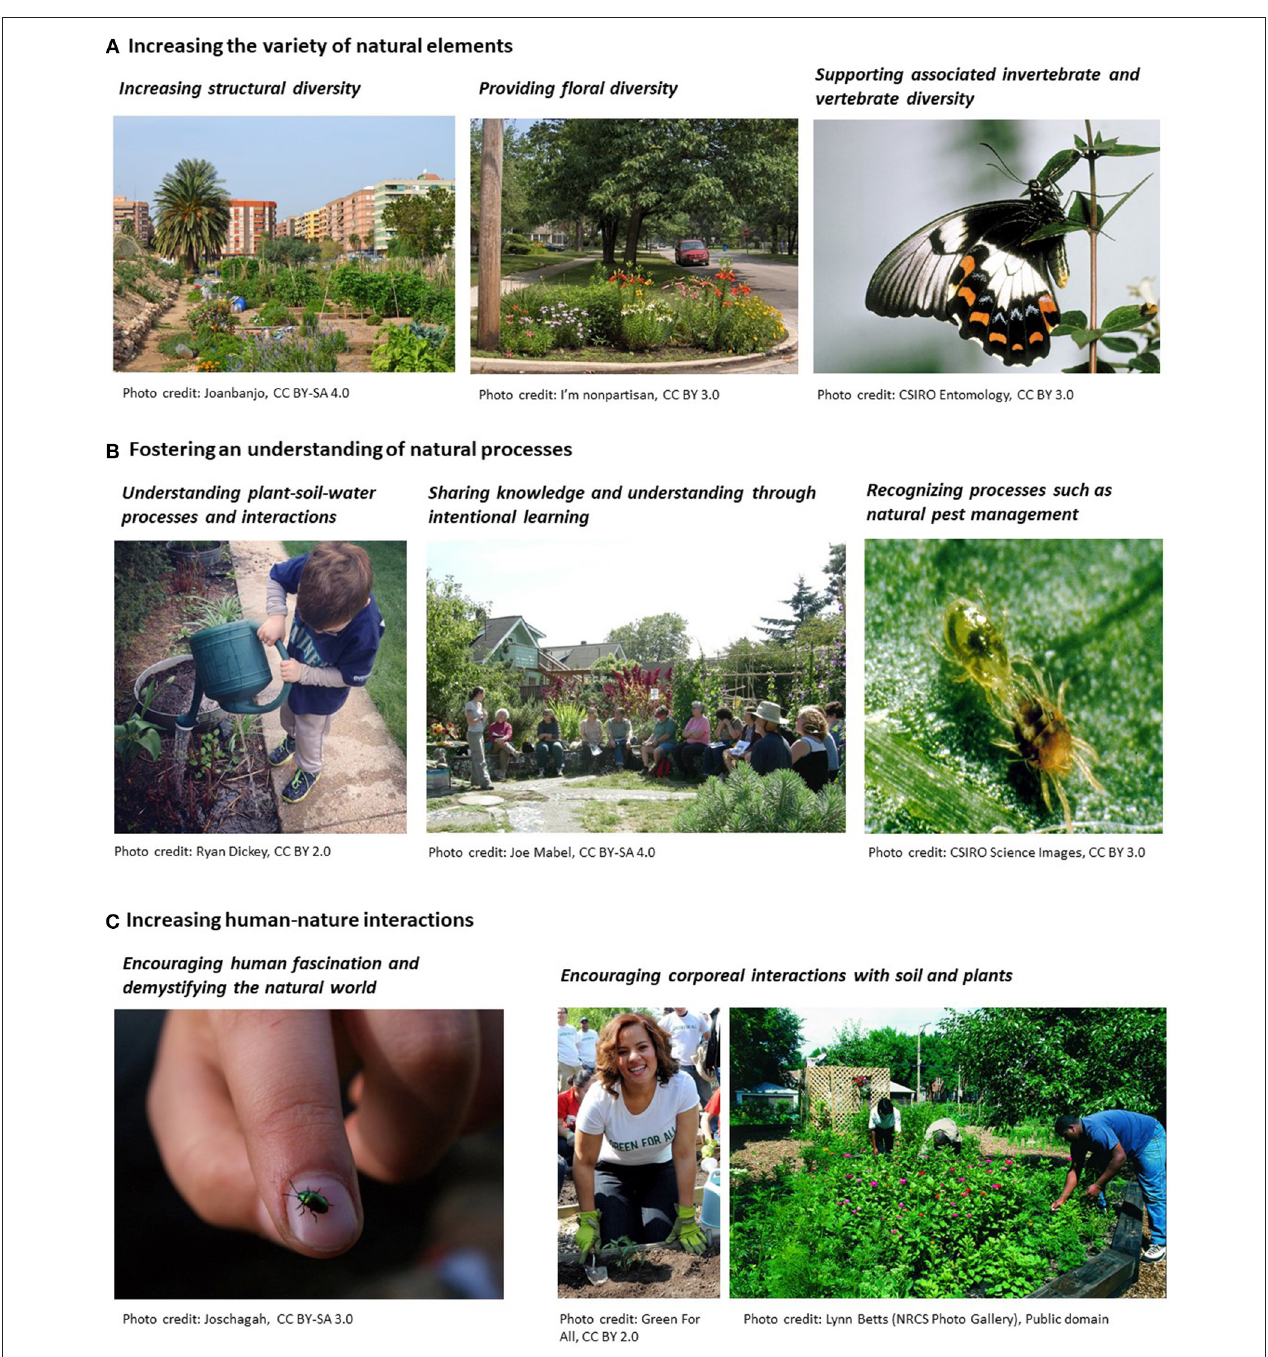
FIGURE 1 | Reimagining gardens with biophilic design thinking requires (A) Bringing in more natural elements to increase the variety of experiences, (B) Fostering human understanding of environmental processes to appreciate natural systems, (C) Considering design methods that encourage greater human-nature interactions. All images are reproduced in this figure based on a Creative Commons license or recognized as public domain. Photo credit and the type of Creative Commons license for each image is found below each image.